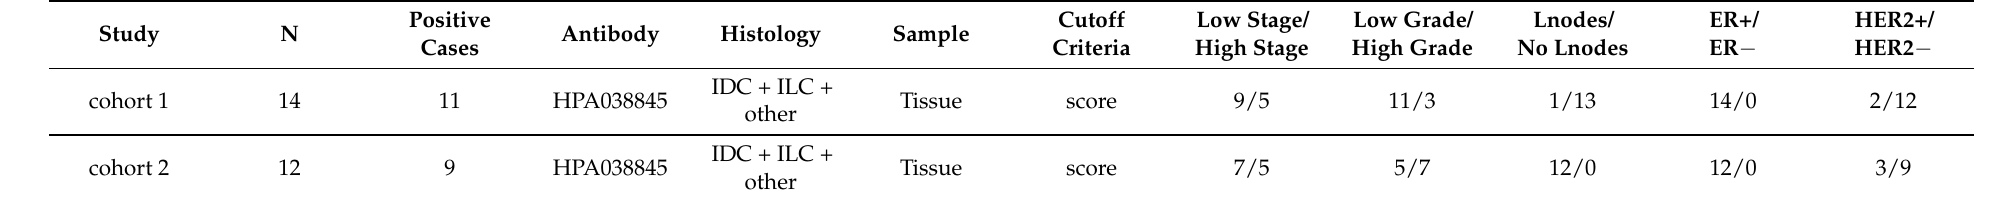
Table 5. Characteristics of the IPO-P’s cohort samples included in the meta-analysis of BiP/GRP78 in breast